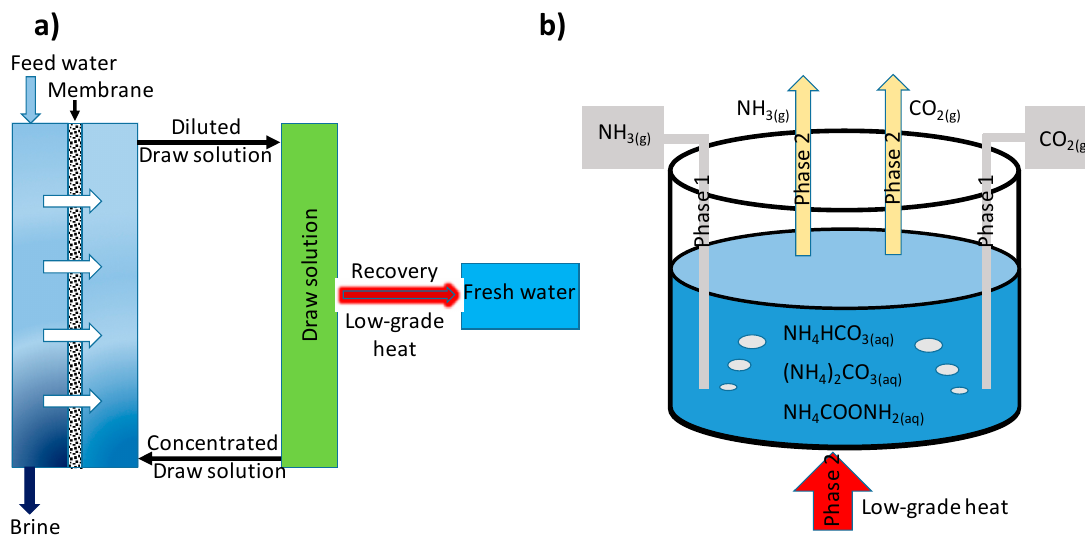
Figure 7. Hybridization of thermal- and membrane-based desalination; ( a ) whole plant, ( b ) draw